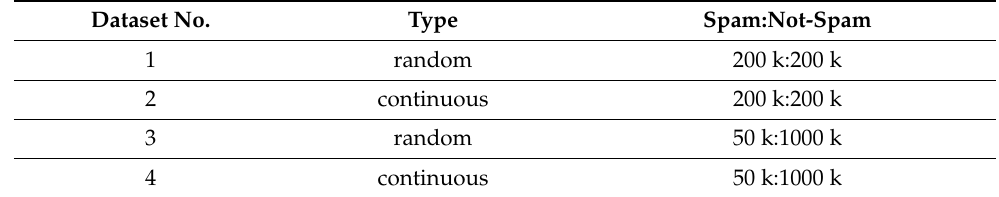
Table 3. Dataset Samples.